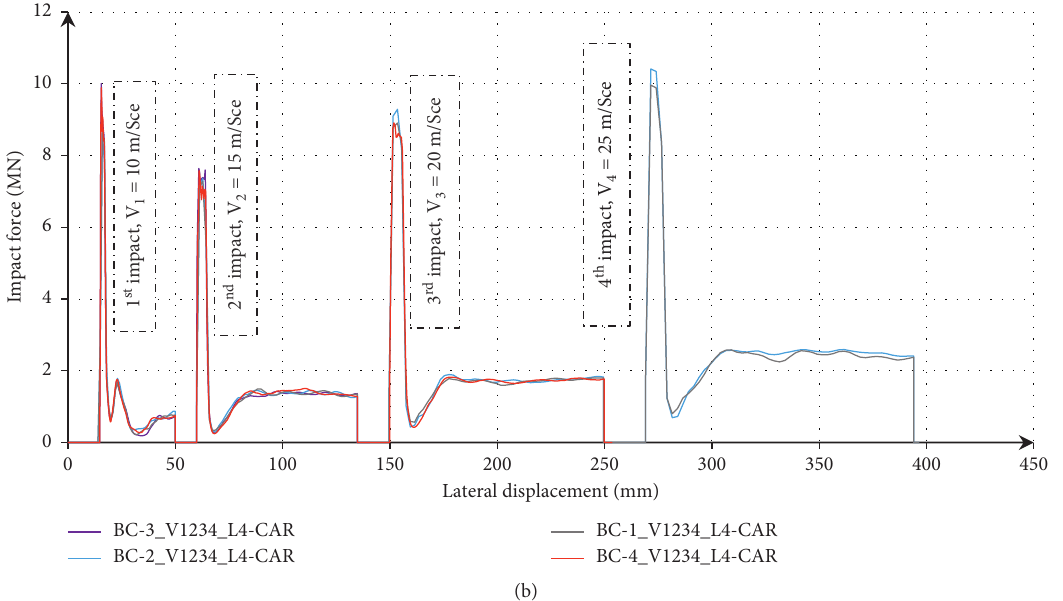
Figure 13: Impact force-lateral displacement curves of BRC columns under variable impact velocity. (a) Single impact scenario. (b) Repeated impact